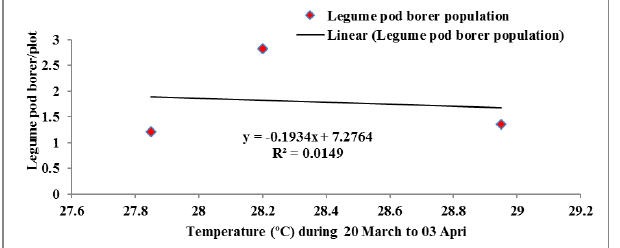
Figure 5: Relationship between the population of legume pod borer and temperature There was a negative correlation (R 2 = -0.086) between the population of legume pod borer and relative humidity was obtained (Figure 6). It indicated that population of legume pod borer was decreased with increasing relative humidity. The regression equation y = a + bx, where y = population of legume pod borer, a = 7.118, b = -0.063 and x = relative humidity. The contribution of the regression (R² = 0.086) was 8.6%.